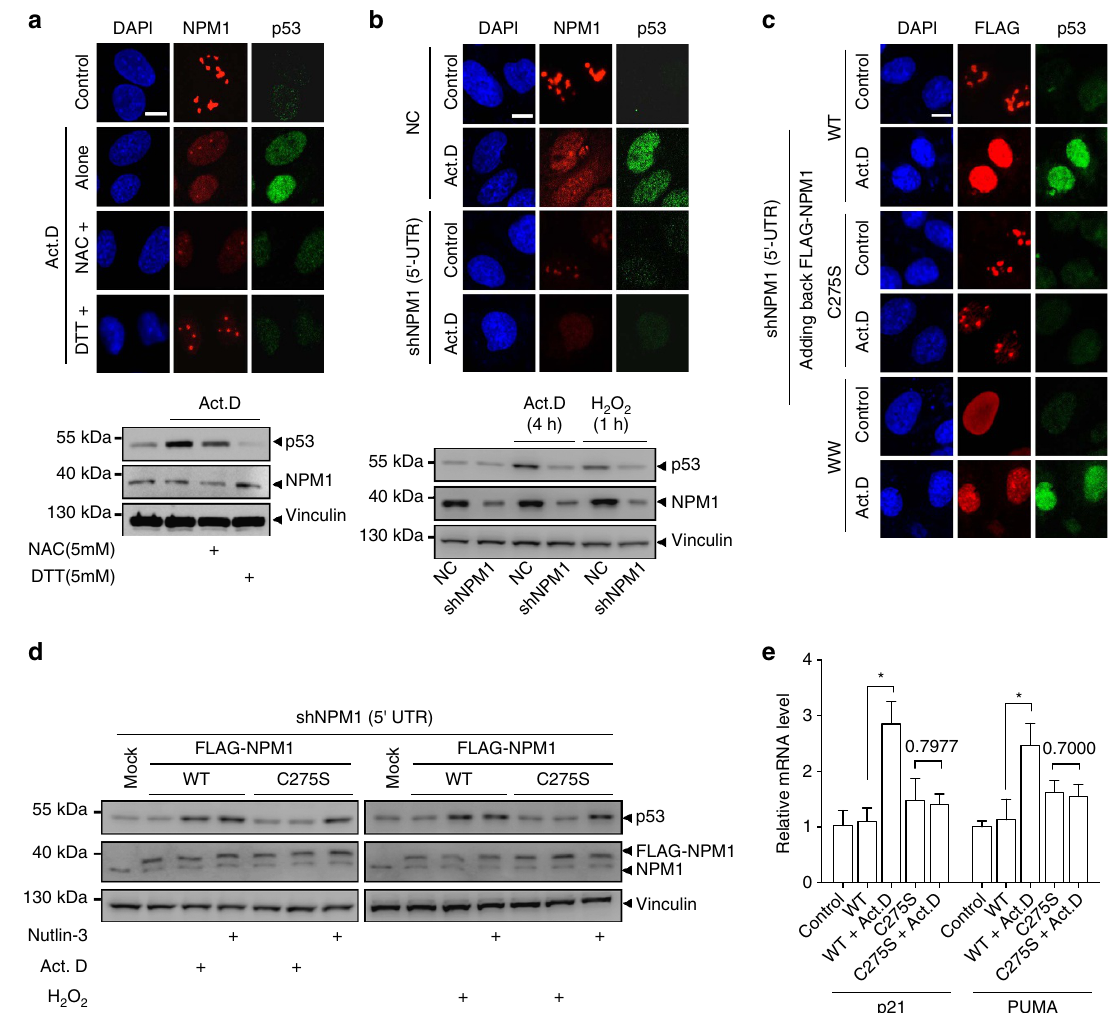
Figure 7 | NPM1 translocation is required for p53 activation. ( a , b ) Endogenous NPM1 translocation and p53 accumulation cells under nucleolar stress with western blot validation. ( a ) Cells were pretreated with NAC (5mM) for 4h before Act.D (8nM) treatment, or co-treated with DTT (5mM) and Act.D (8nM). Nucleolar line profiles of NPM1 in representative cells are shown in Supplementary Fig. 6a. ( b ) NPM1 was silenced with shRNA (shNPM1 5 0 -untranslated region (UTR)) before Act.D treatment or H 2 O 2 (500 m M). ( c ) Immunofluorescence for endogenous p53 accumulation in NPM1-silenced cells (shNPM1 5 0 -UTR) that added back FLAG-NPM1 WT, C275S or WW mutants before treatment with Act.D. Line profiles of p53 in representative cells were showed in Supplementary Fig. 6c. ( d ) p53 accumulation after Act.D (left) or H 2 O 2 (right) treatment in NPM1-silenced cells which were added back WT or C275S mutant of NPM1. Endogenous and exogenous FLAG-NPM1 were blotted with anti-NPM1 antibody. Nutlin-3 was used as a positive control for p53 inducer. ( e ) Relative mRNA level changes of p21 and PUMA after Act.D treatments in NPM1-silenced cells (shNPM1 5 0 -UTR) that added back FLAG-NPM1 WT or C275S mutants. Unpaired t -test. * P o 0.05 or showed above the bars. Data were represented as mean ± s.e.m. Scale bars, 10 m m. WW, W280/290A. All of the experiments were performed in U2OS